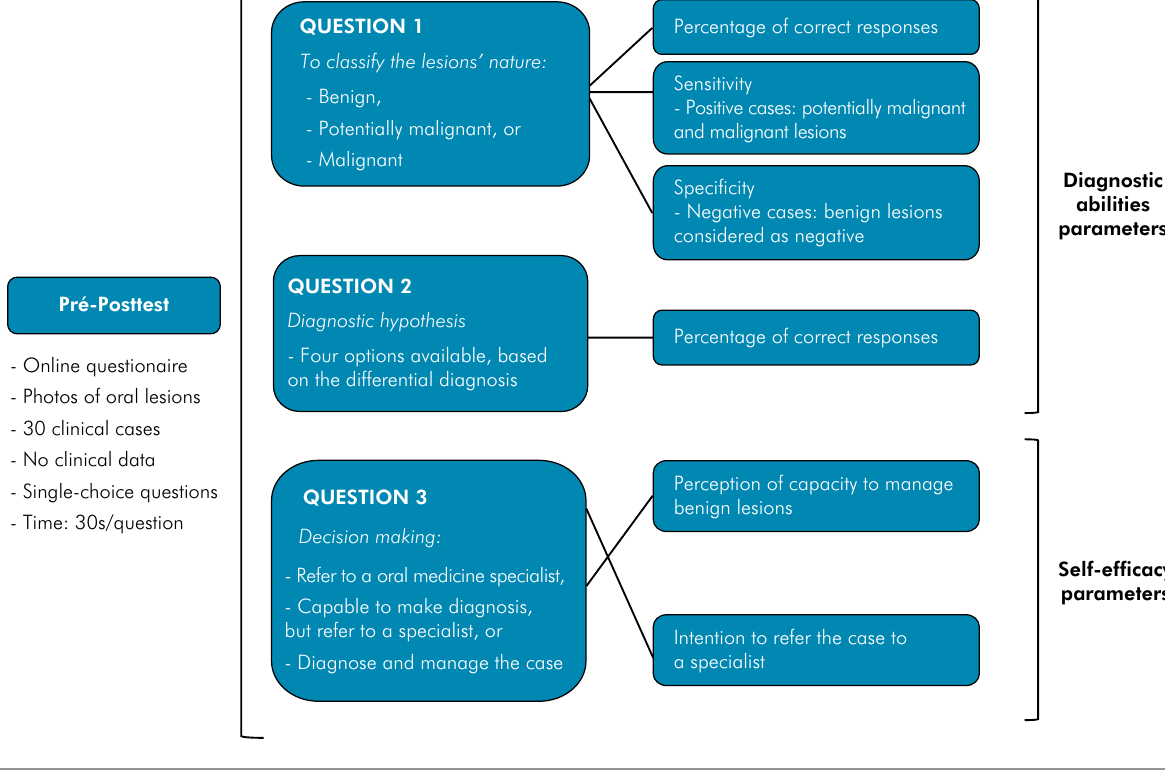
Figure 1. Evaluation strategy to assess the impact of distance learning course on the diagnostic abilities of the participants.